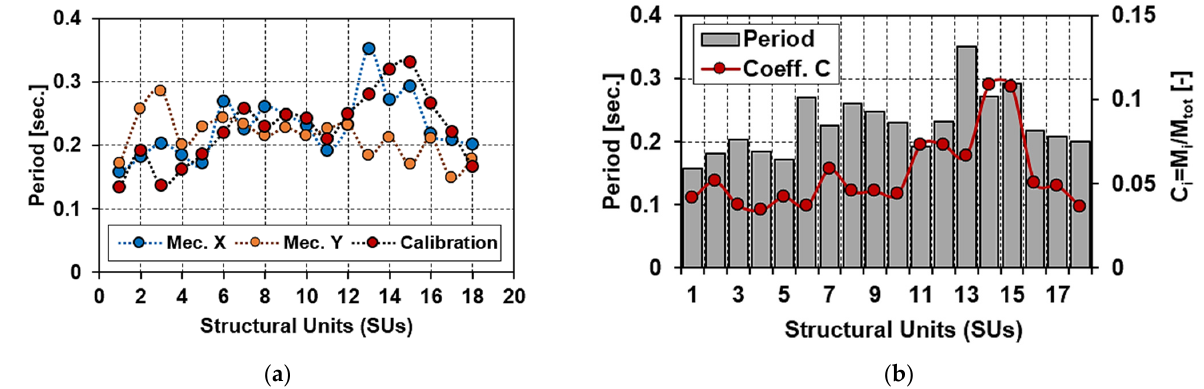
Figure 17. Comparison of mechanical and empirical vibration periods ( a ) and ( b ) variation of the coefficient C i for each SUs.